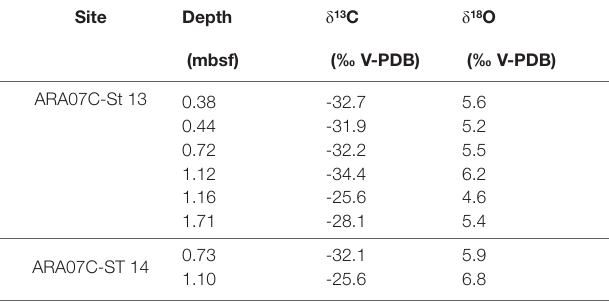
TABLE 2 | Carbon and oxygen isotopic values of MDACs collected during the ARA07C Expedition.